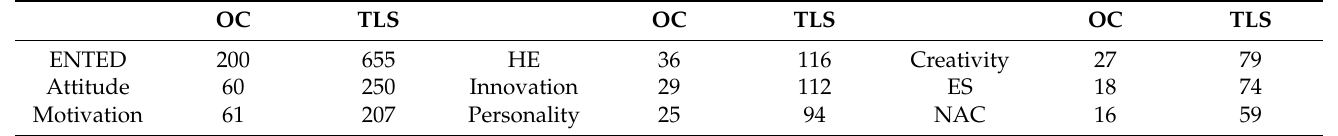
Table 6. EI: Co-occurrences and total link strength of business-related selected keywords.